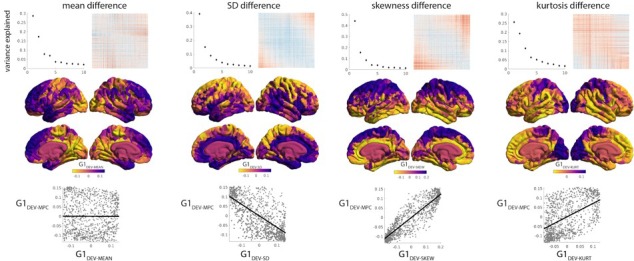
Developmental gradients derived from moment difference.Absolute difference in MT moment values between each pair of regions was calculated for each participant and transformed into a node x node matrix. In the same manner as developmental gradient construction, linear mixed effects models estimated the age-related changes of each edge and the resultant t-statistic matrix was subjected to diffusion map embedding. Variance explained by diffusion embedding components, t-statistic matrices ordered by the first components, the first components projected onto the cortical surface, scatterplot depicting the similarity of moment-based developmental gradients (G1AGE-MOMENT) to MPC-based developmental gradients (G1AGE-MPC; Figure 4B).